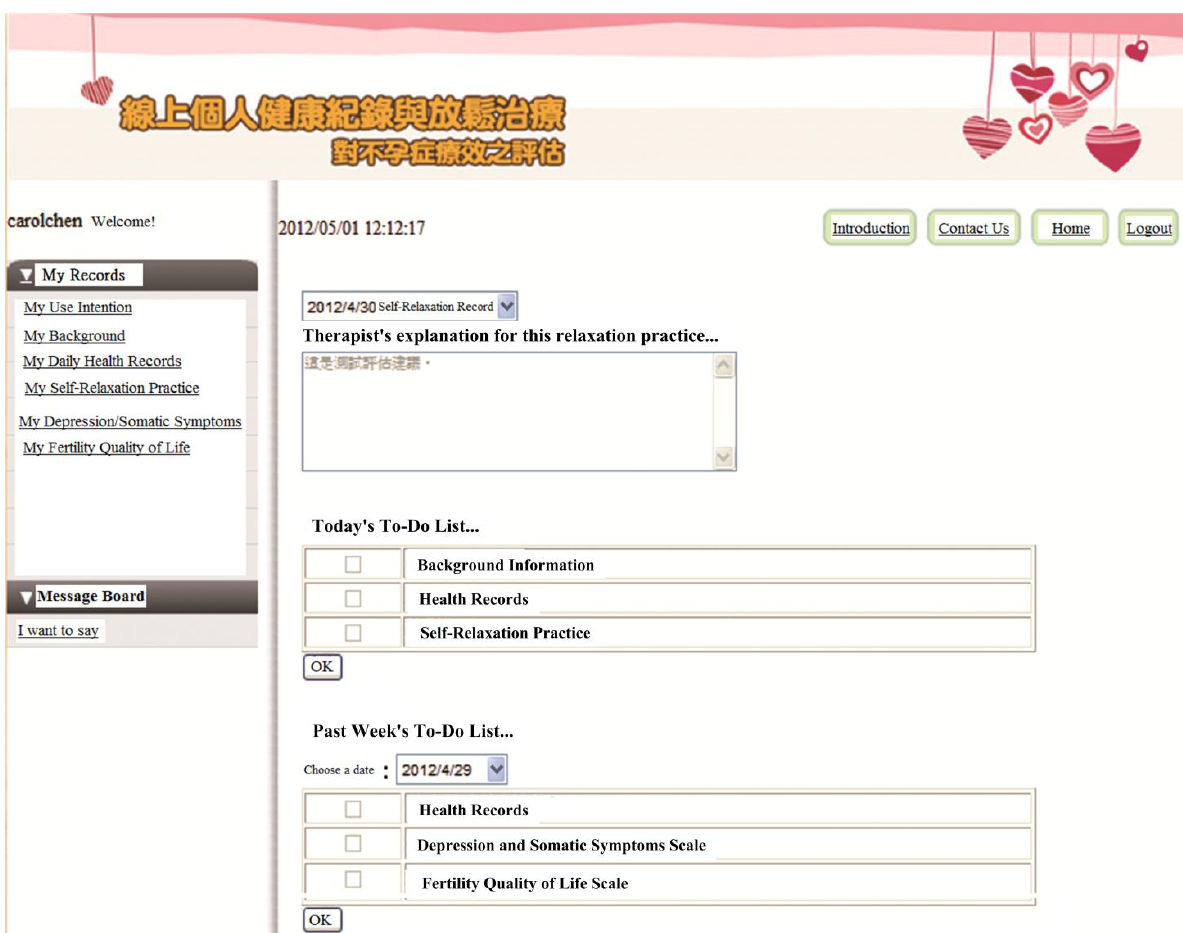
Figure 1. The post-login page of the PHR